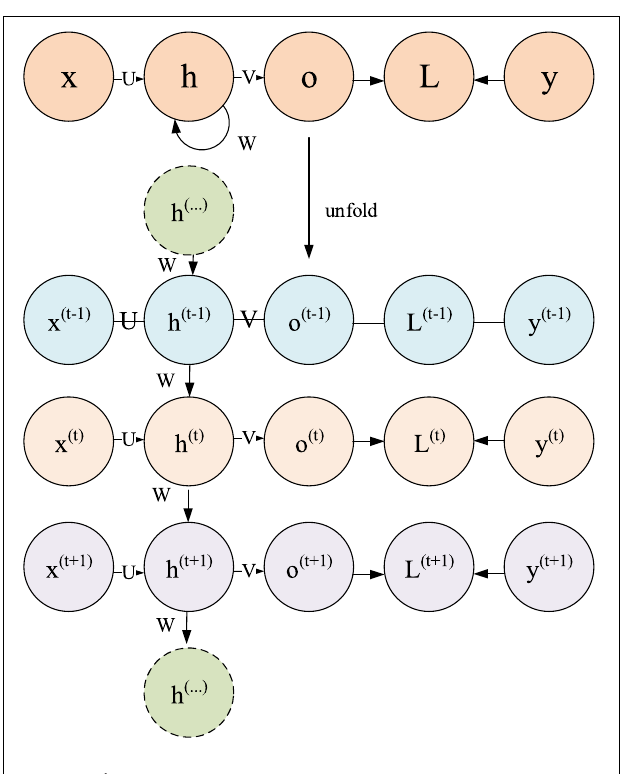
FIGURE 5 | Recurrent neural network